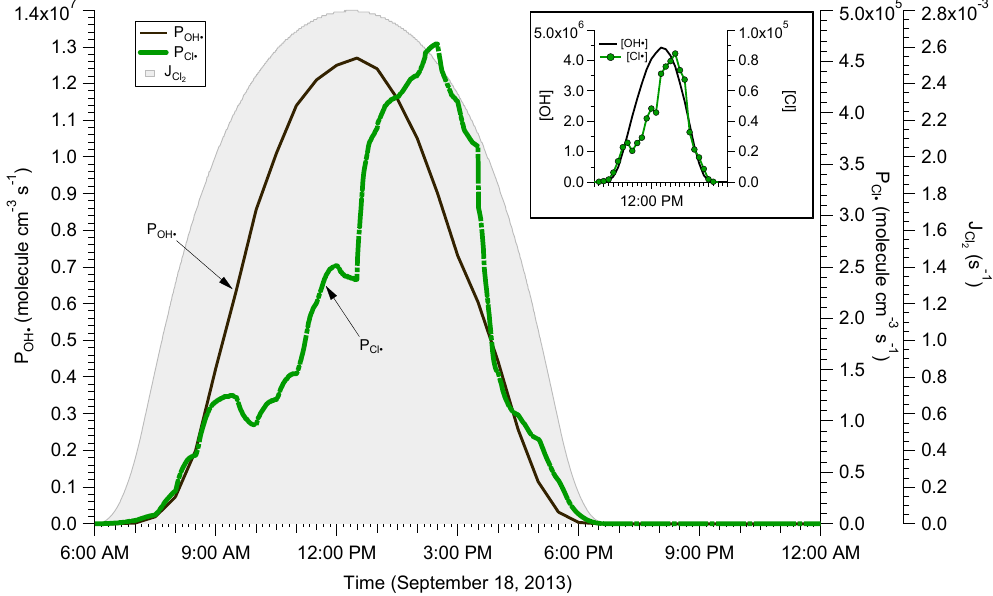
Figure 6. Production of OH and Cl radicals in a box modeling simulations for the conditions on 18 September 2013. The inset shows calculated concentrations of OH and Cl radicals in molecules·cm − 3 · s − 1